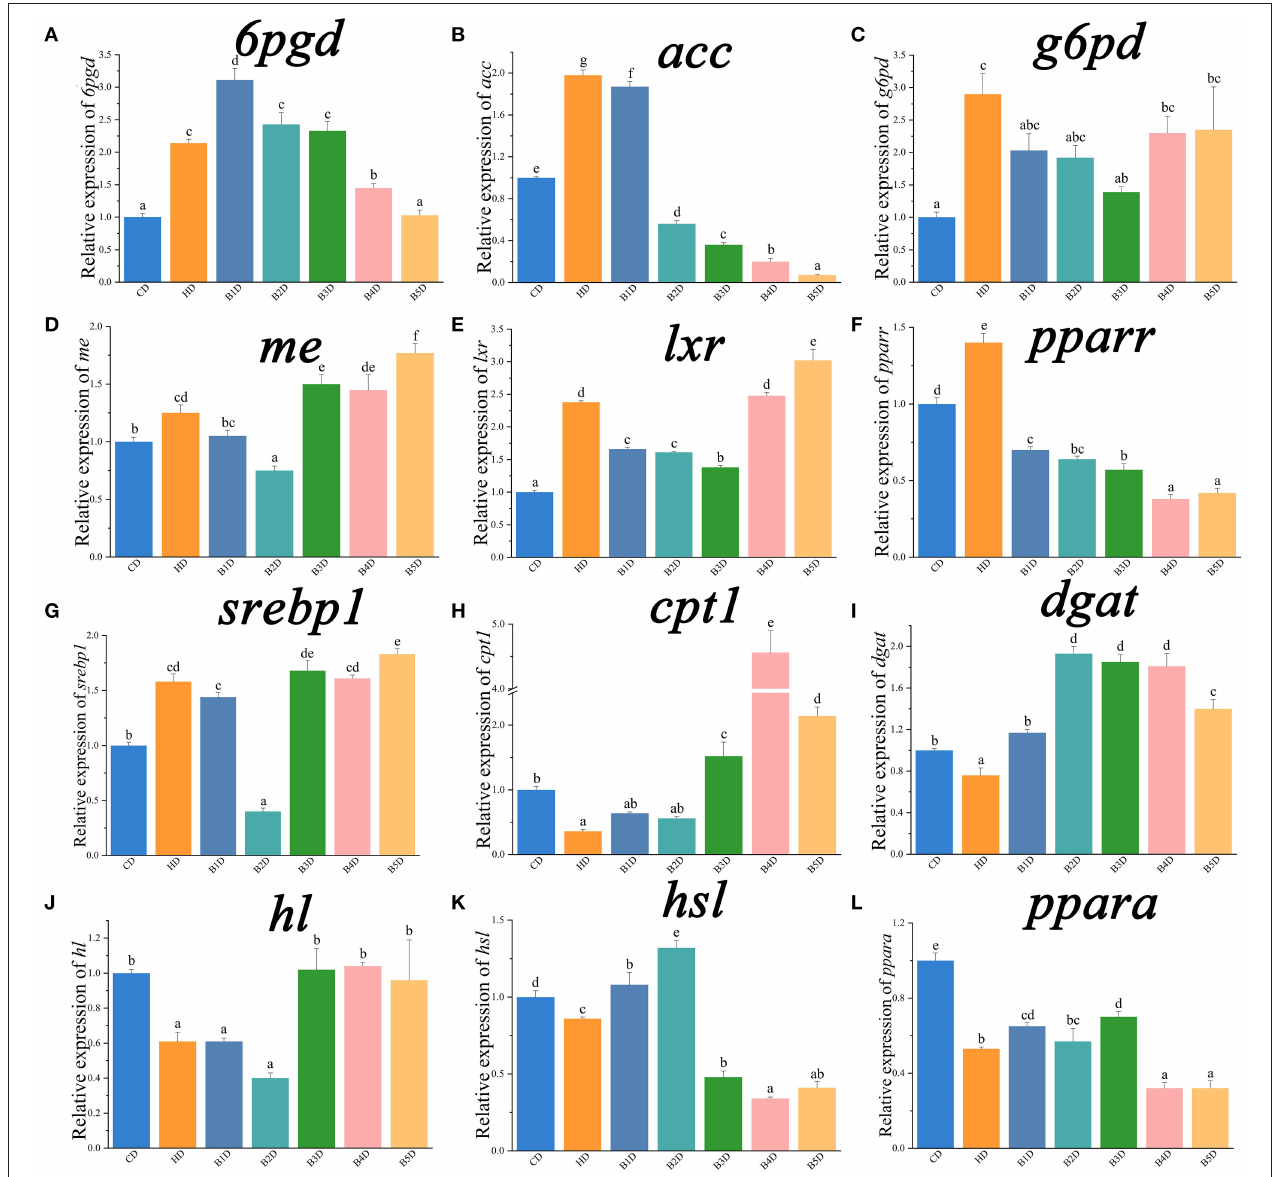
FIGURE 7 | The relative expression of genes associated with lipid metabolism in the liver (part 1). 6pgd , 6-phosphogluconate dehydrogenase; acc , acetyl-CoA carboxylase; g6pd , glucose 6-phosphate dehydrogenase; me , malic enzyme; lxr , liver X receptor alpha; pparr , peroxisome proliferator activated receptor gamma; cpt1 , carnitine palmitoyltransferase 1; dgat , acyl CoA diacylglycerol acyltransferase 2; hl , hepatic lipase; hsl , hormone-sensitive lipase. Data are normalized to 18s (18S ribosomal RNA) and β -actin as the reference genes and presented as a fold change in relation to the control group (CD, set as 1) ( n = 6). Values are presented as means with SD, where significant ( p < 0.05) differences between groups are indicated by different